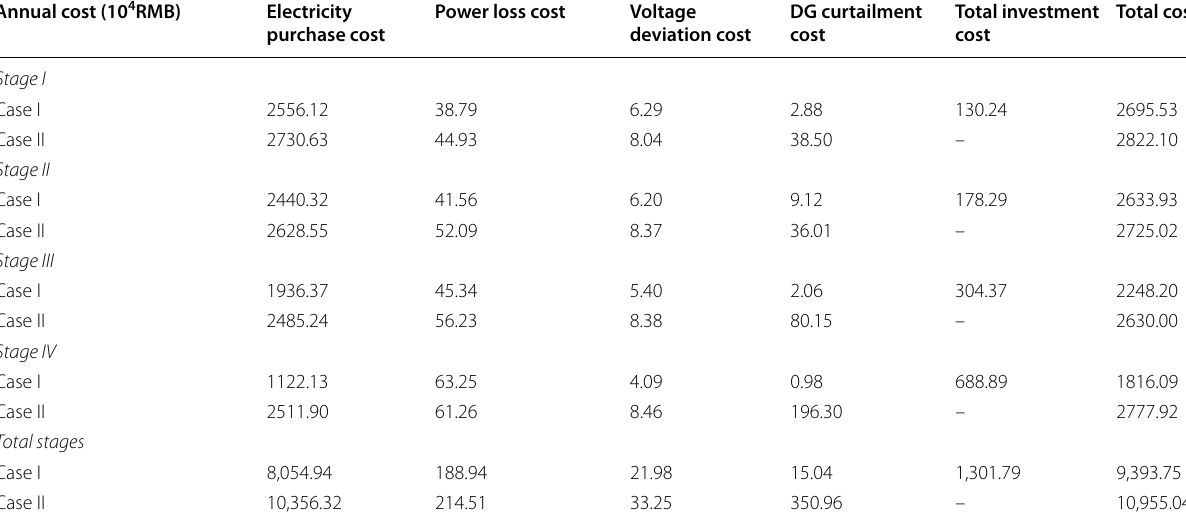
Table 5 Cost–benefit result in multiple stages Annual cost (10 4